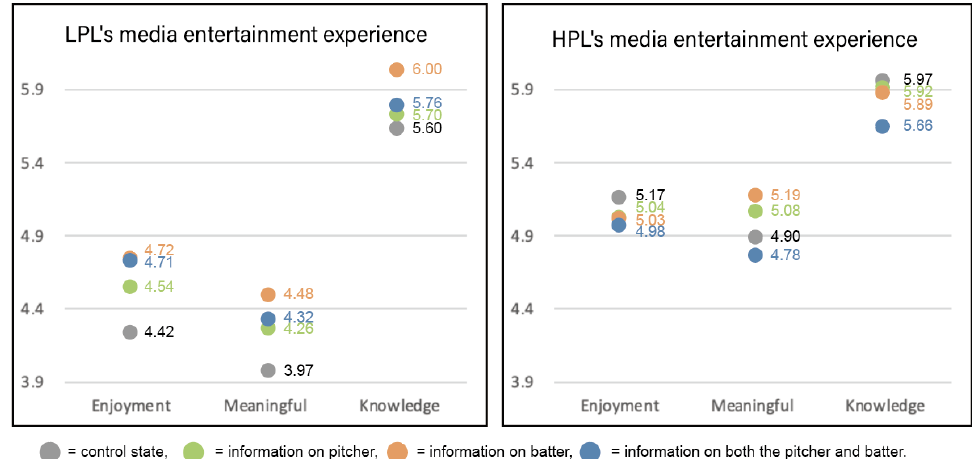
Figure 5. The use of visualized information is very different for different ethnic groups, and the use of visualized information is more positive on LPL. of visualized information is more positive on